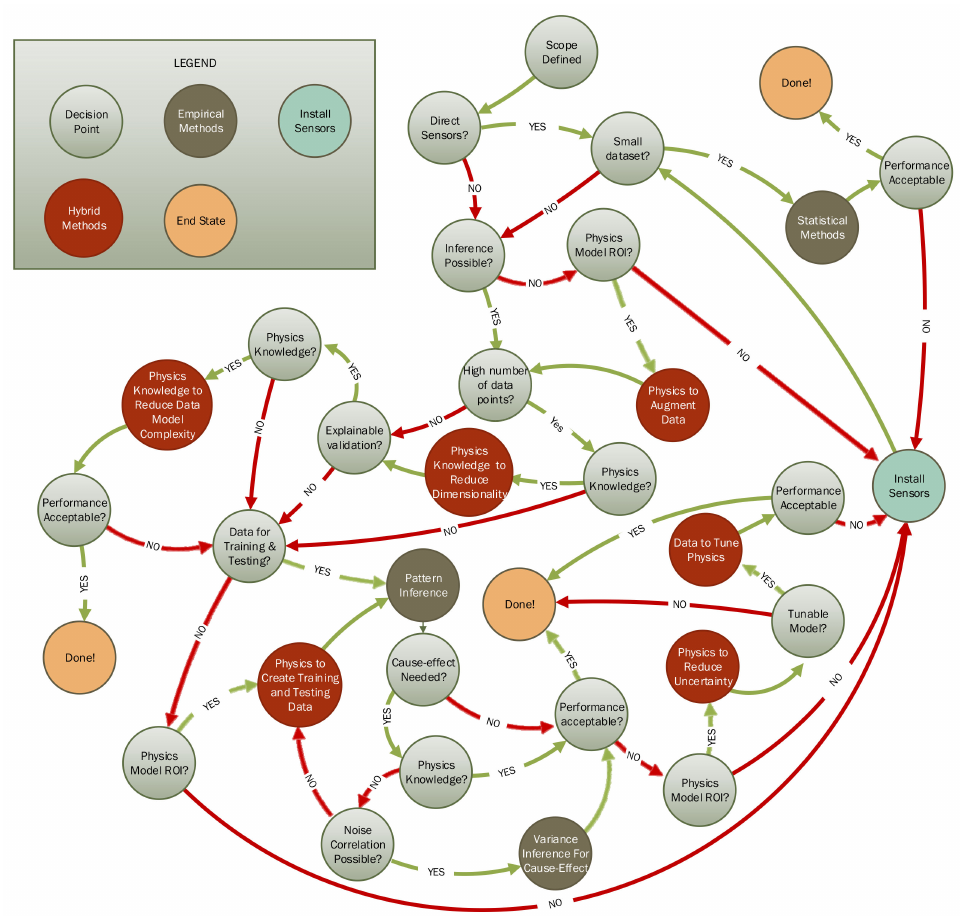
Figure 2. Strategy of empirical and hybrid models introduced in a decision-state